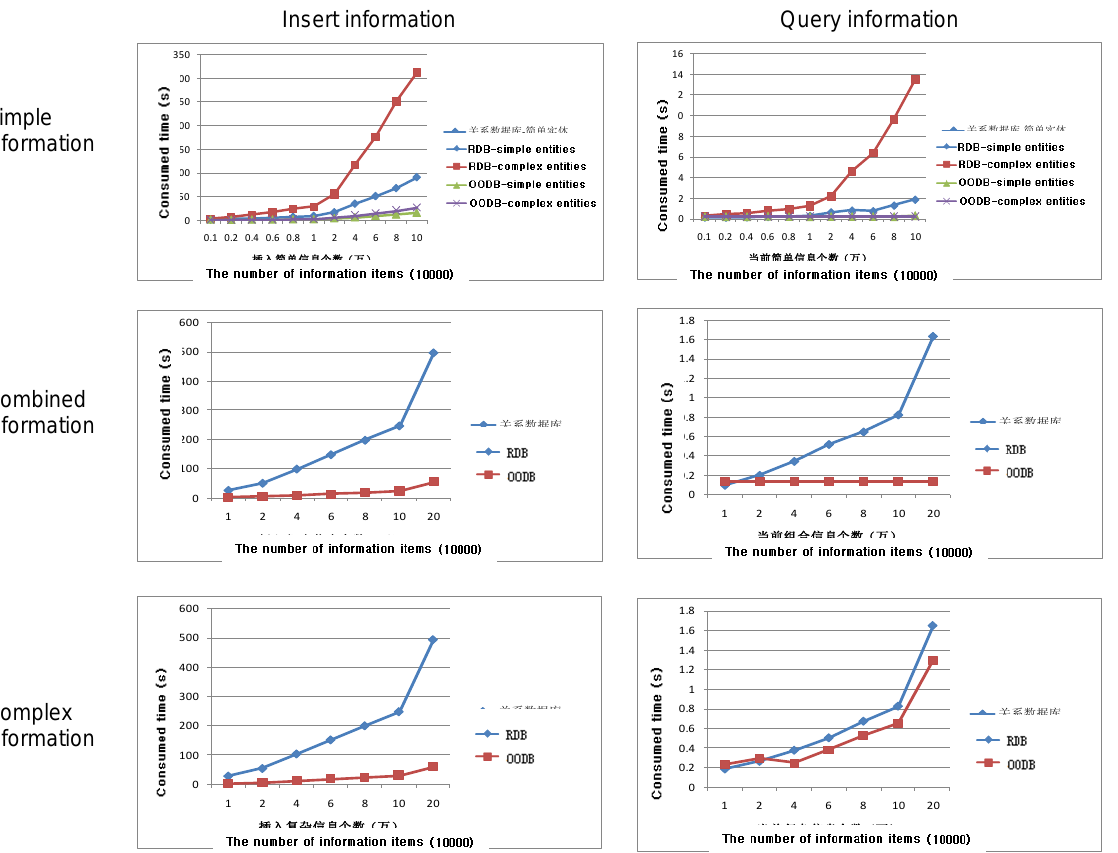
Figure 6 Comparison of OODB and RDB for the efficiency of manipulating IFC data (Ma